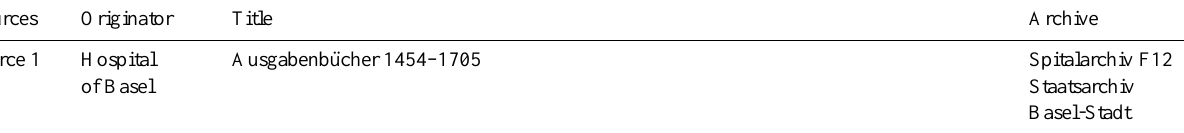
Table 1. Archival- and edited archival